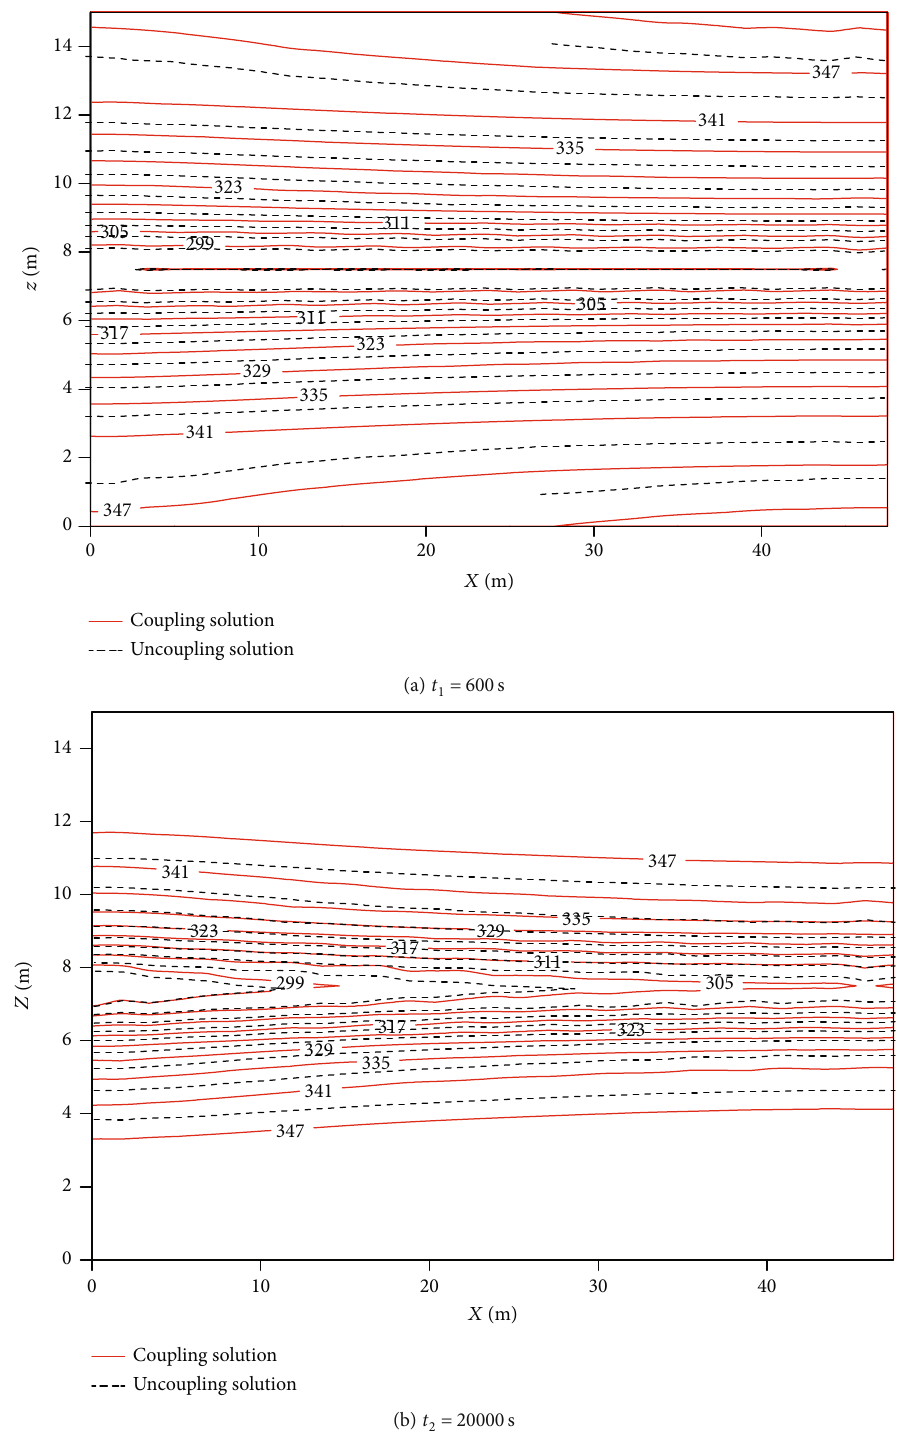
Figure 6: Comparison of the thermal fi eld in x ‐ z plane when the coupling e ff ect is considered or not at di ff erent